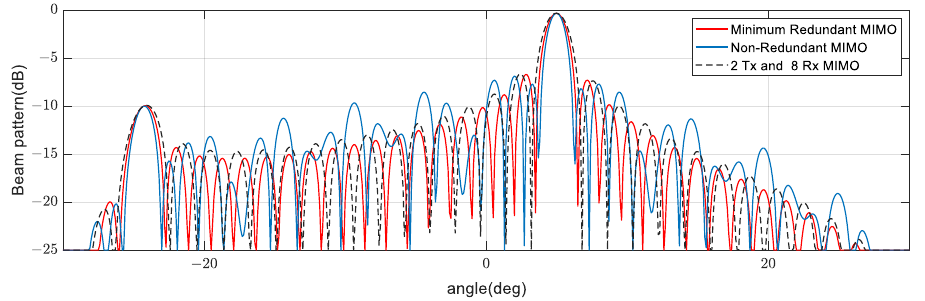
Figure 18. Comparison of beampatterns steered to 5°. The non-redundant MIMO has the smallest beamwidth but the worst sidelobe characteristic. Grating lobes are common.